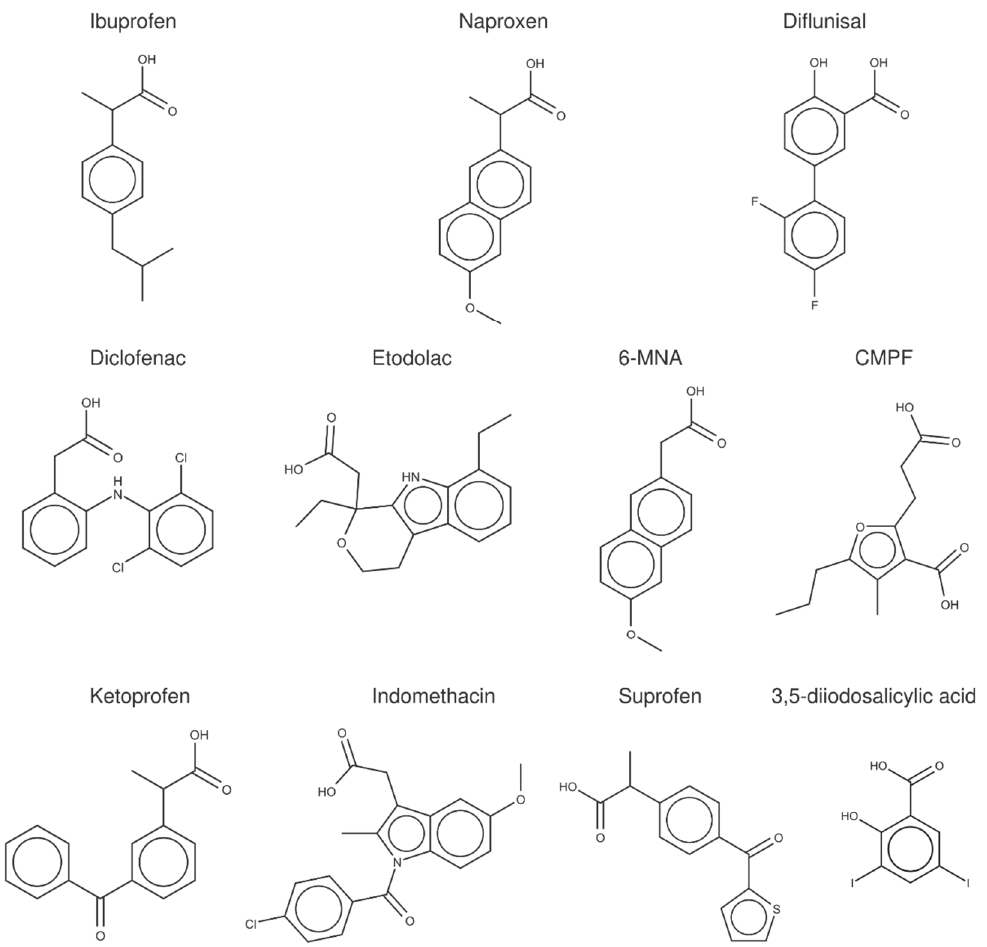
Figure 3. Chemical structures of the NSAIDs and related compounds included in the analysis of X-ray crystallographic structures.